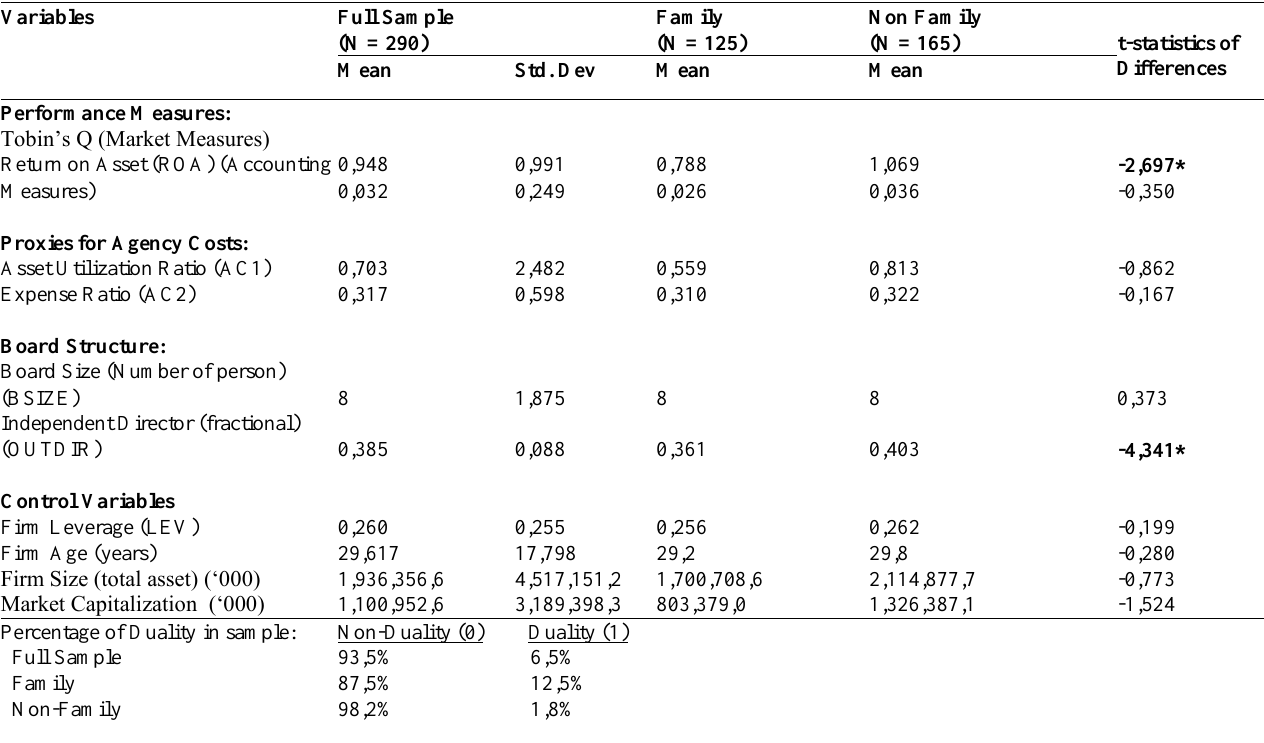
Table 1: Descriptive statistics and differences of mean test of family ownership and non family ownership in Malaysia for year 1999 to 2005